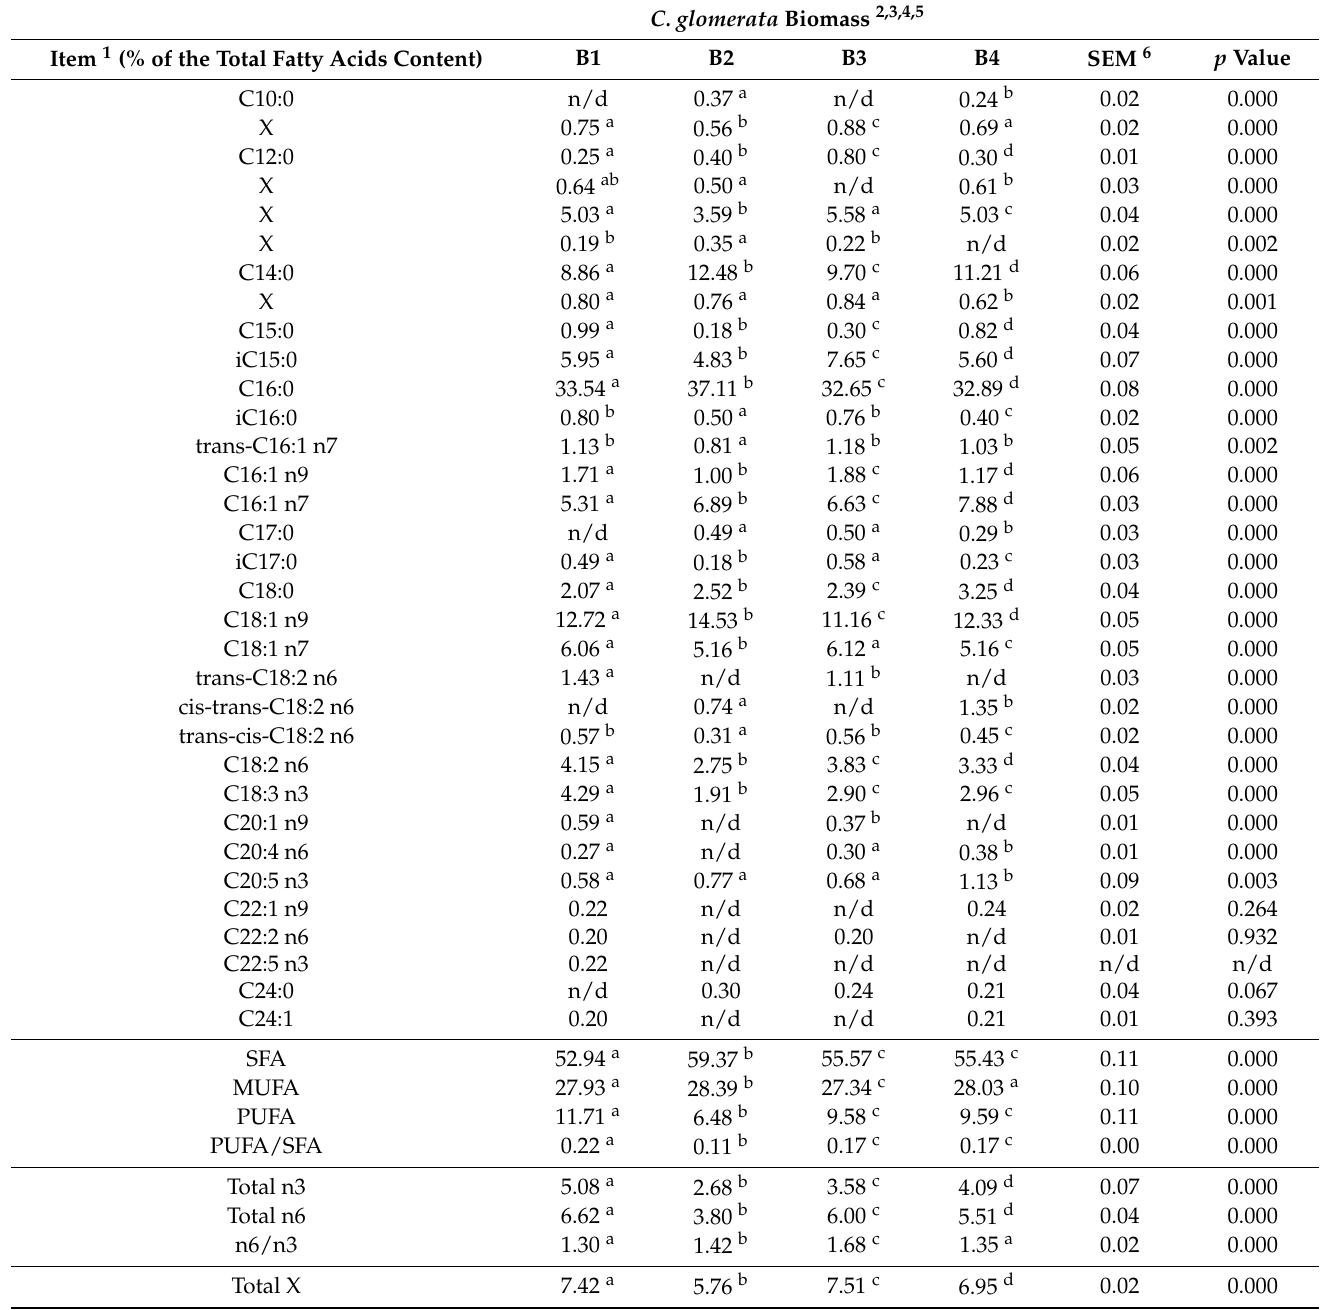
Table 5. Fatty acids profile of C. glomerata biomass from different rivers in